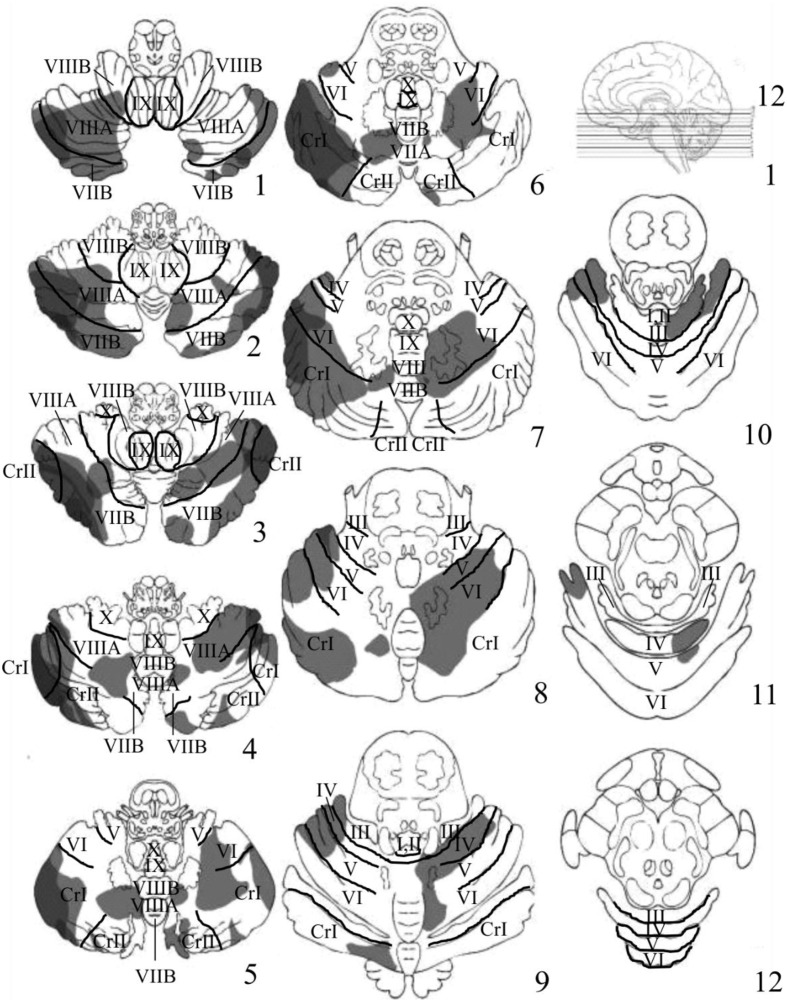
Depicts the results of the lesion overlay analysis for the cerebellar patients (n = 11). Lesioned areas in each patient were manually traced onto a series of 12-4 mm thick axial cerebellar slices based on the templates first developed by Tatu et al. (1996). Structural labels and anatomical boundaries were determined by comparing sections of the cerebellar template with horizontal MRI and histology sections from the MRI Atlas of the Human Cerebellum (Schmahmann, 2000). Slice 1 starts at the most inferior portion of the cerebellum and moves upward in 4 mm increments toward more superior portions of the cerebellum. Gray portions represent the area of the patient's lesions. Darker gray regions represent areas of significant overlap between patients. The regions of greatest overlap were in Crus I and Crus II of the lateral cerebellum.